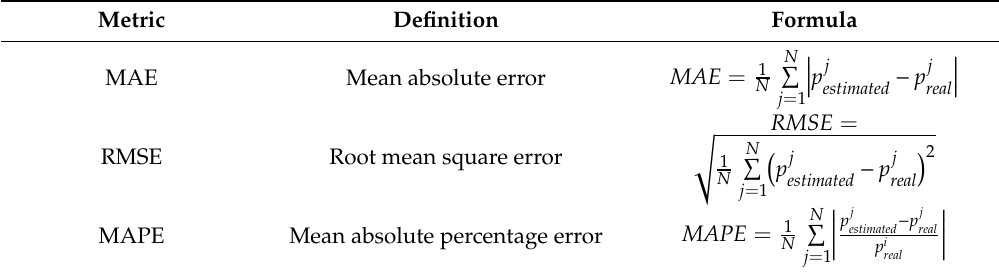
Table 1. Model performance metrics.